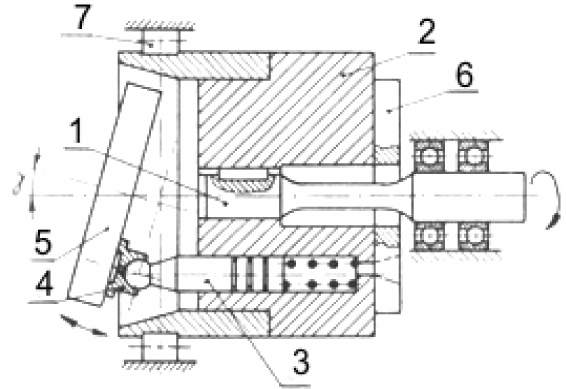
Figure 1. Simplified design diagram of an axial piston pump with a swashplate: 1—shaft, 2—rotor, 3—piston, 4—sliding shoe, 5—swashplate, 6—valve plate, 7—bearing [28].